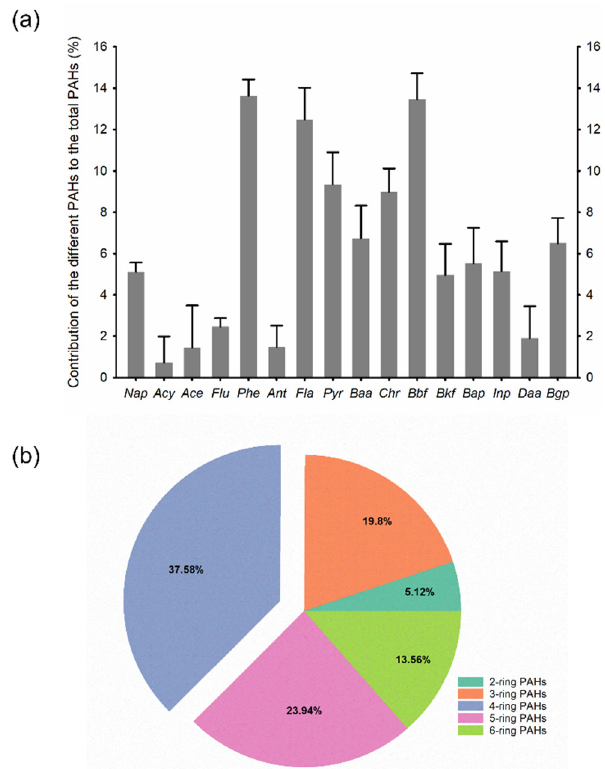
Figure 2. Proportion of individual PAHs ( a ) and PAHs with different ring numbers ( b ) in the soil samples. carcinogenic PAHs. Naphthalene (Nap); acenaphthylene (Acy); acenaphthene (Ace); fluo- rene (Flu); phenanthrene (Phe); anthracene (Ant); fluoranthene (Fla); pyrene (Pyr); benz[a] anthracene (Baa); chrysene (Chr); benzo[b] fluoranthene (Bbf); benzo[k] fluoranthene (Bkf); benzo[a] pyrene (Bap); indeno[1,2,3-cd] pyrene (Inp); dibenzo[ah]anthracene (Daa); and benzo[ghi] perylene (Bgp).